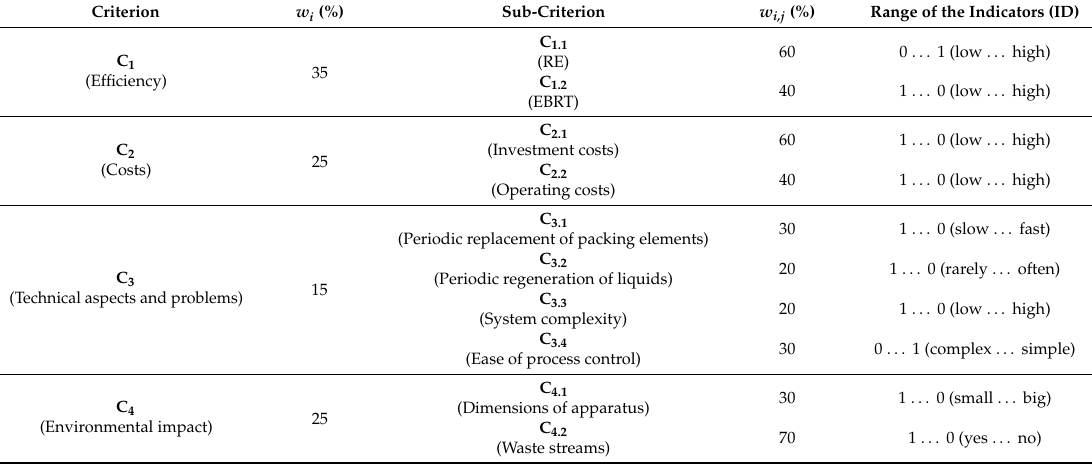
Table 1. Weight of the criteria and sub-criteria and ranges of sub-criteria indicators. Criterion w i